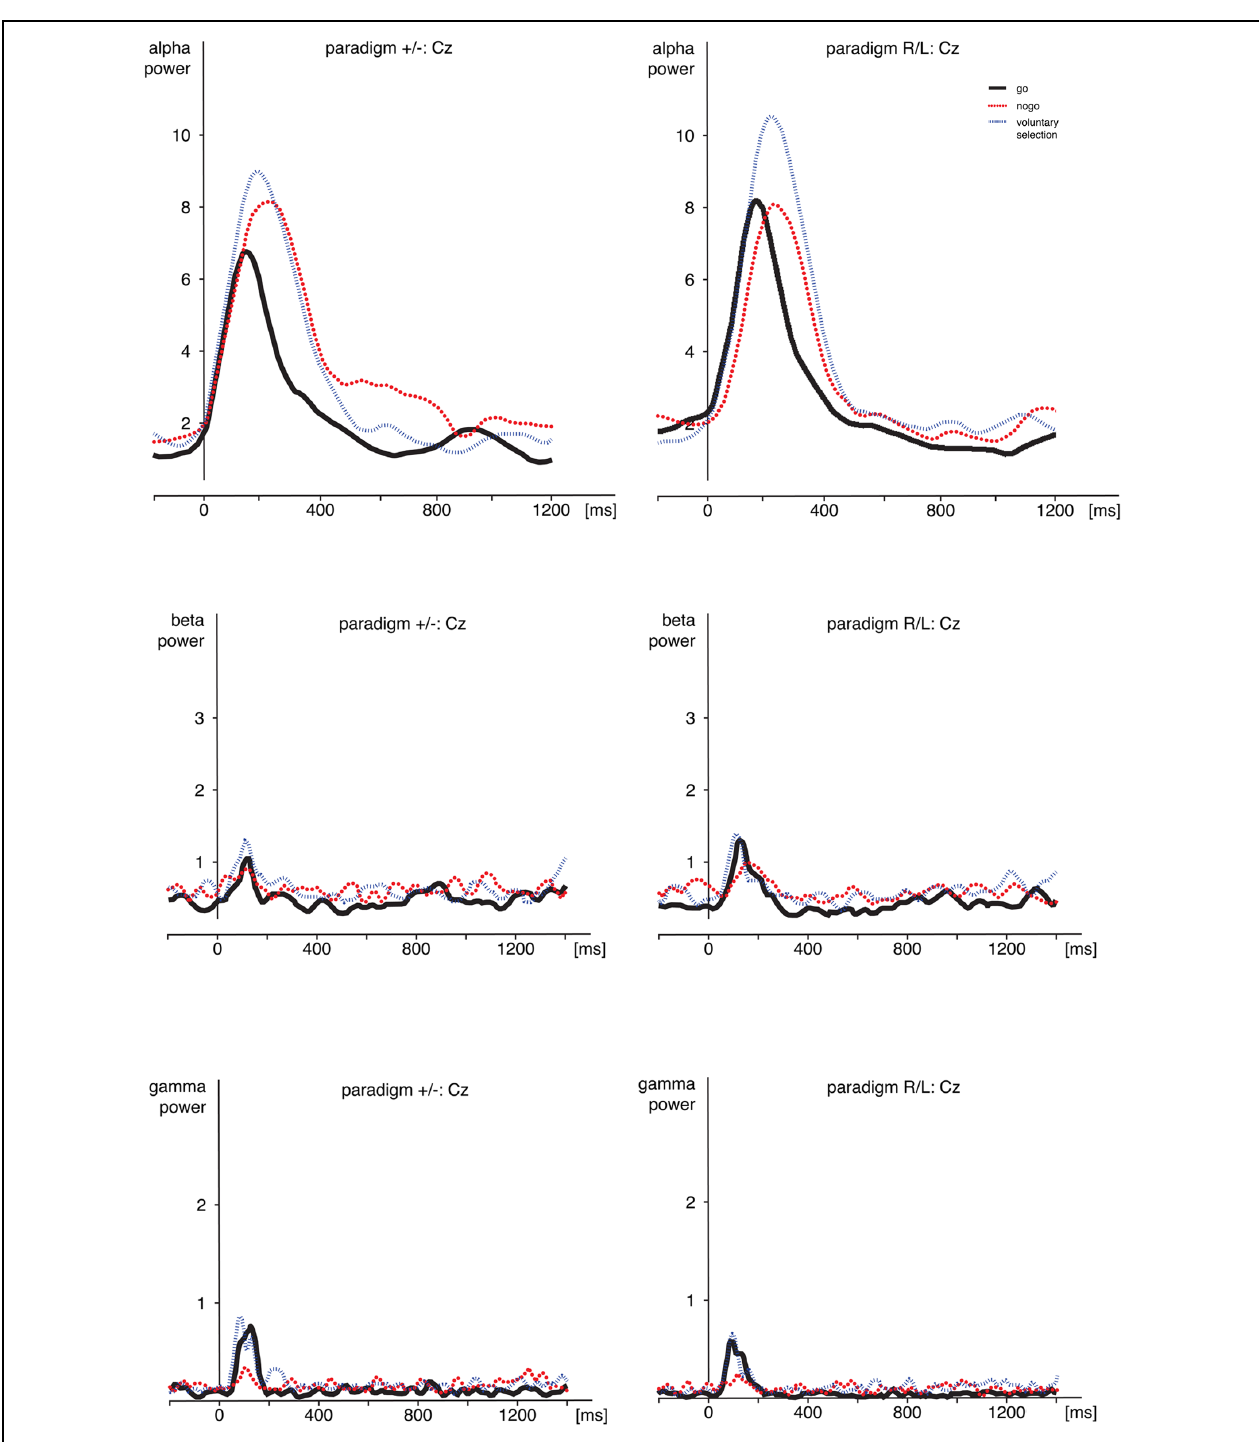
FIGURE 4 | Time frequency analyses. Comparison of alpha-, beta-, and gamma-power during go , nogo, and voluntary selection in Cz. Activity was increased during voluntary selection compared to go and nogo condition. ms,